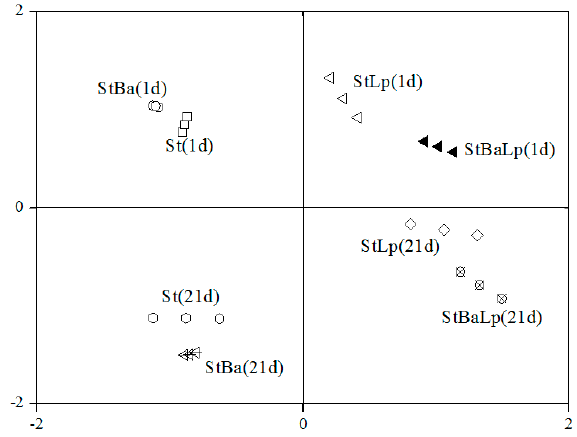
Figure 3. Loadings based on the principal component analysis of the free amino acid